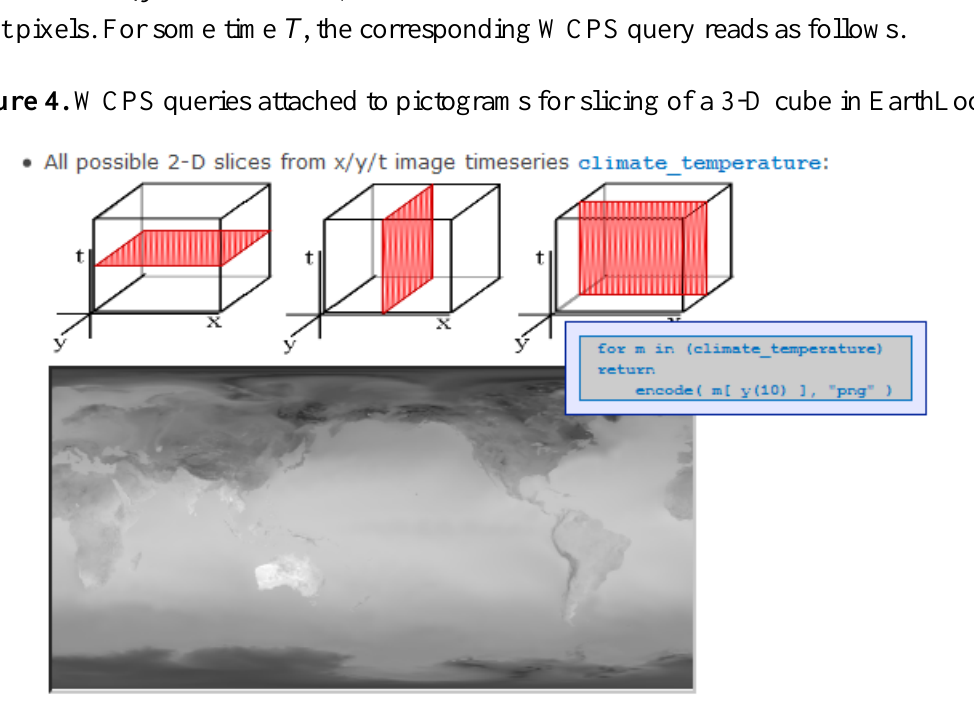
Figure 5. Masking time series images to isolate land (left) and sea areas